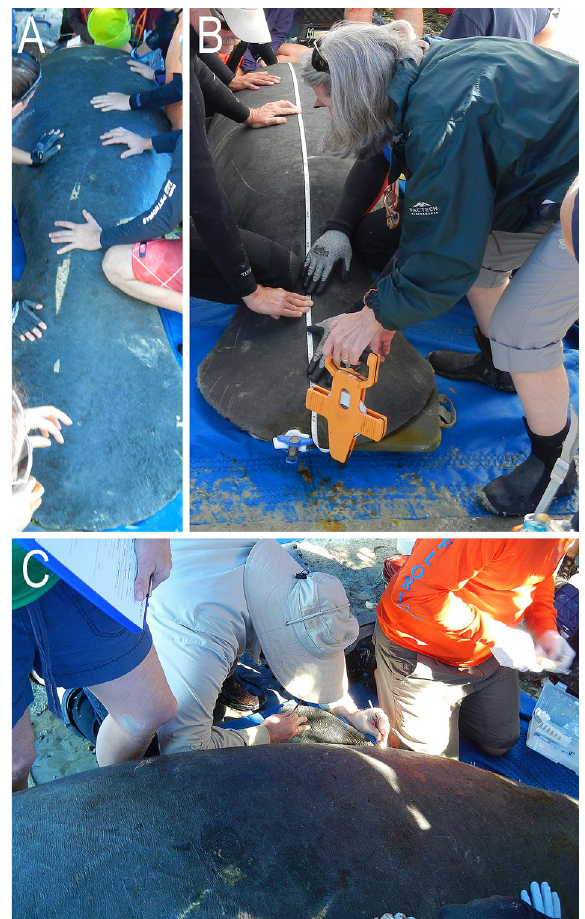
Figure 3. Manatee skin sampling during health assessment. ( A ) Manatee under tent on beach while veterinary personnel perform diagnostics. ( B ) Curvilinear length being measured. ( C ) Skin sample being collected from under the